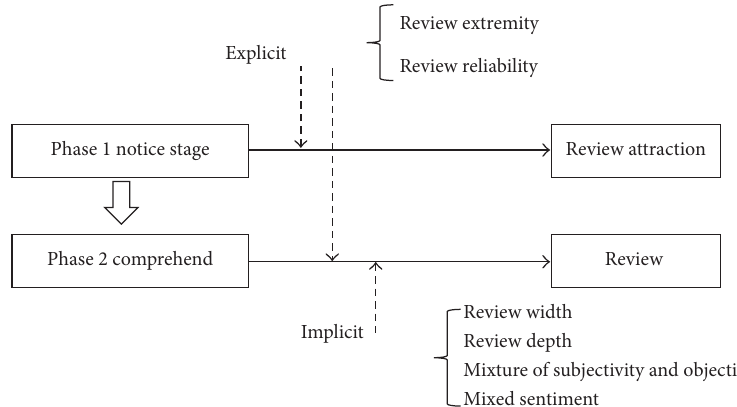
Figure 1: Relationship among key